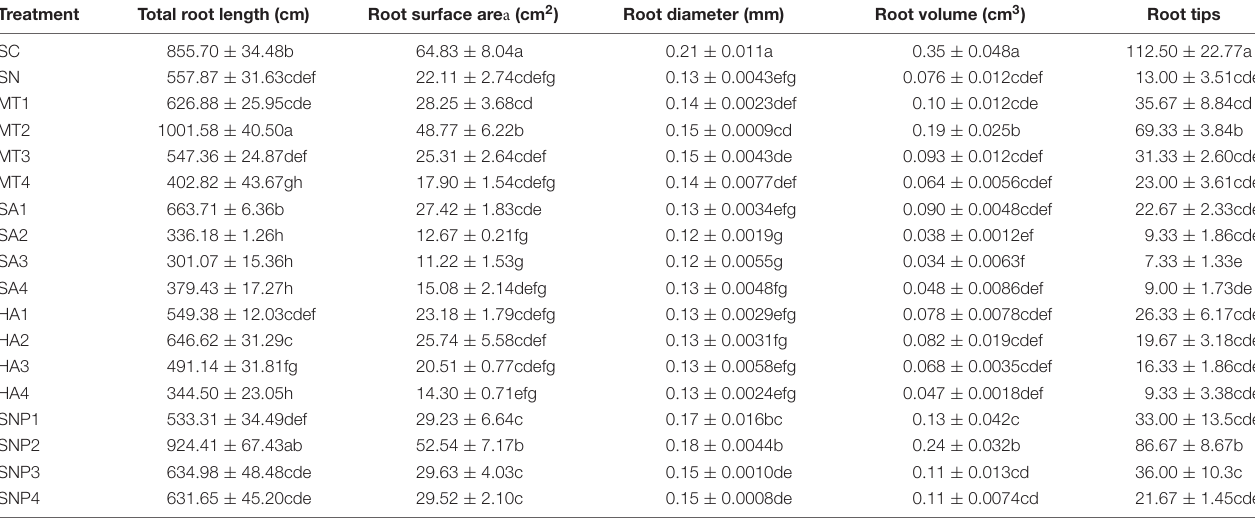
TABLE 3 | Effects of exogenously applied plant growth regulators on root morphology of tomato under high-nitrate stress. Treatment Total root length (cm)